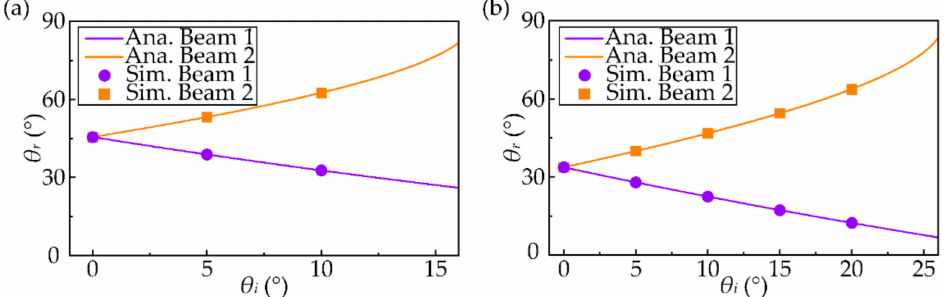
Figure 6. Analytical and simulated results of the reflected angle θ r at different incident angles ( a ) in the case of a = 1.4 λ 0 and ( b ) in the case of a = 1.8 λ 0 .